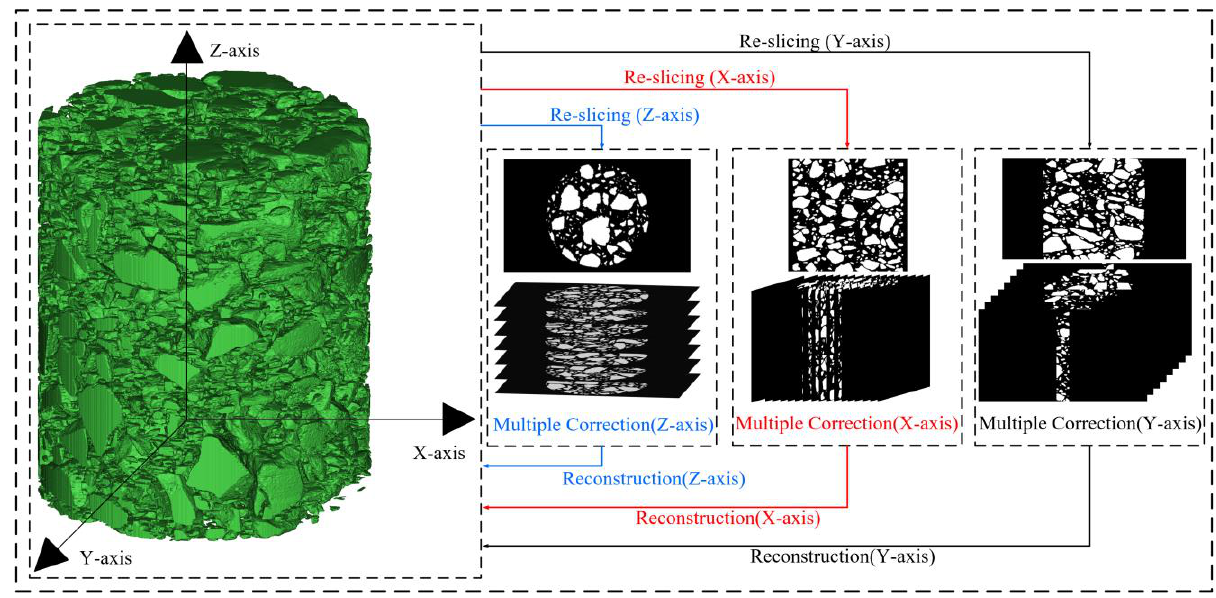
Figure 6. Schematic diagram of the multi-directional multiple-correction method.